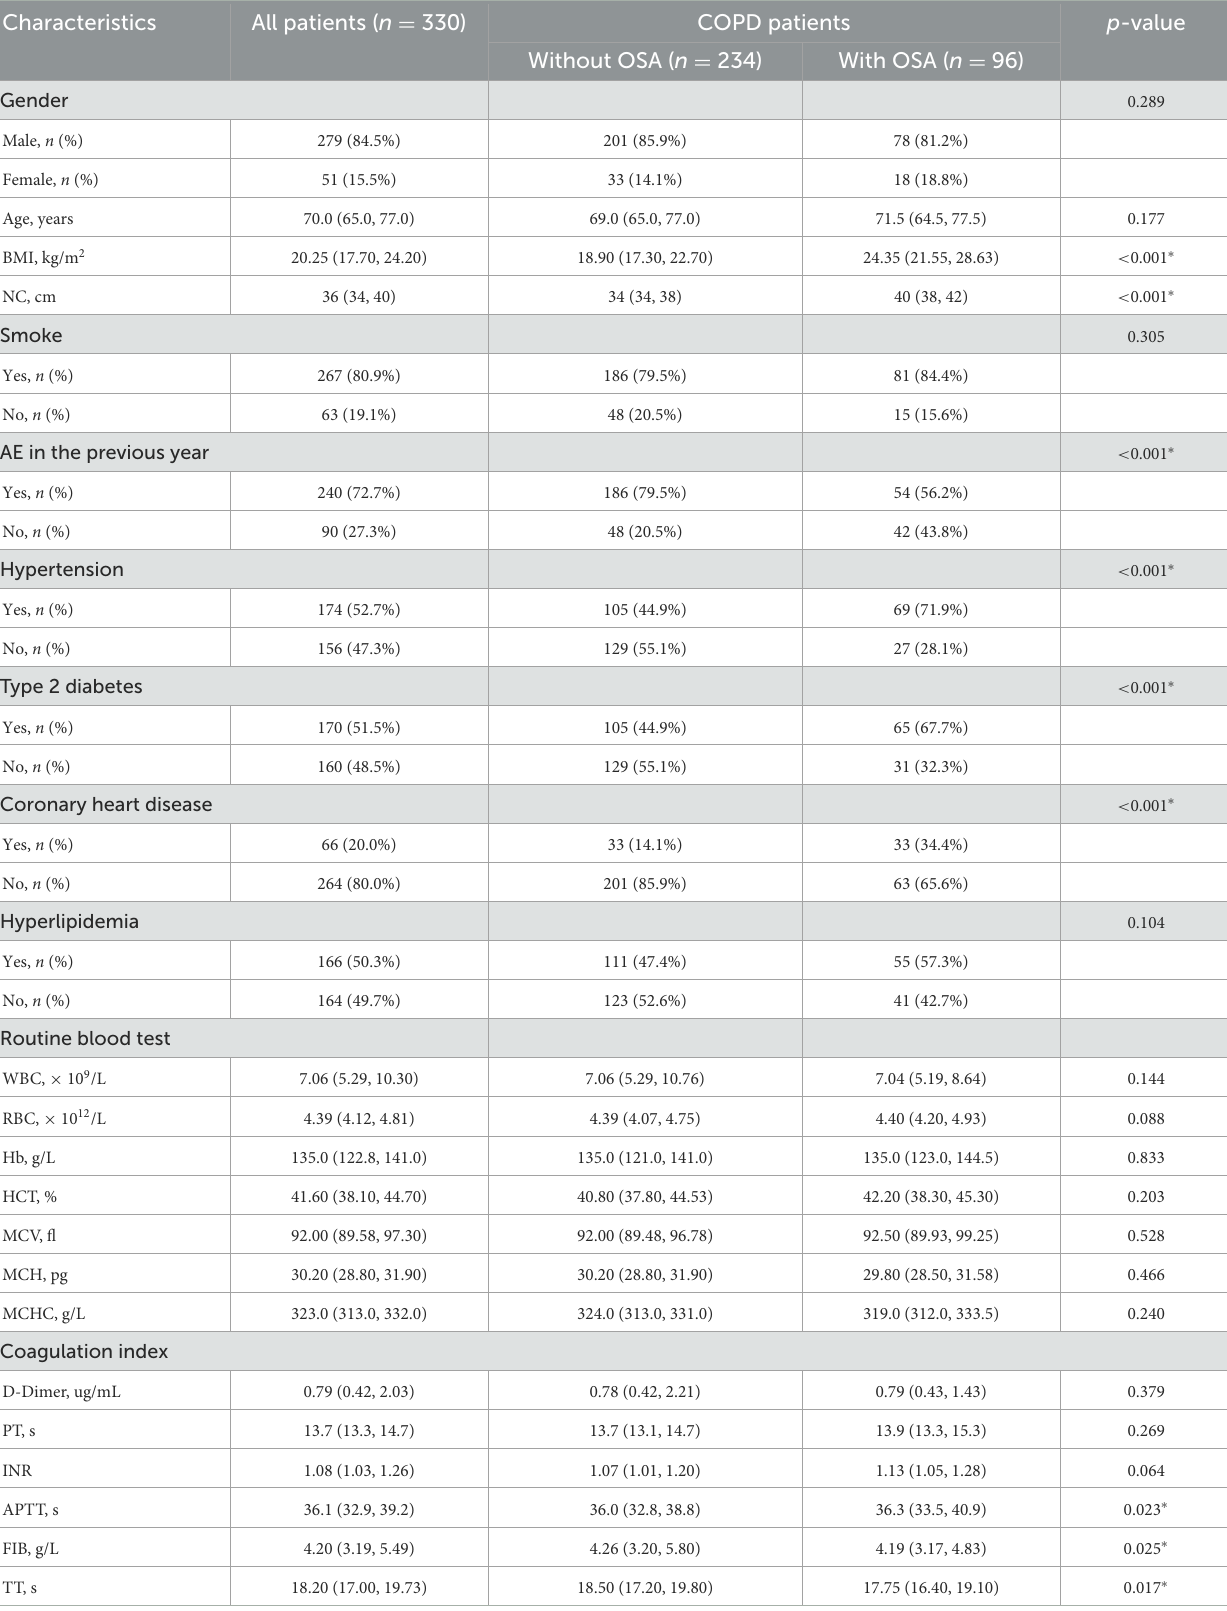
TABLE 1 Demographics and clinical characteristics of patients with